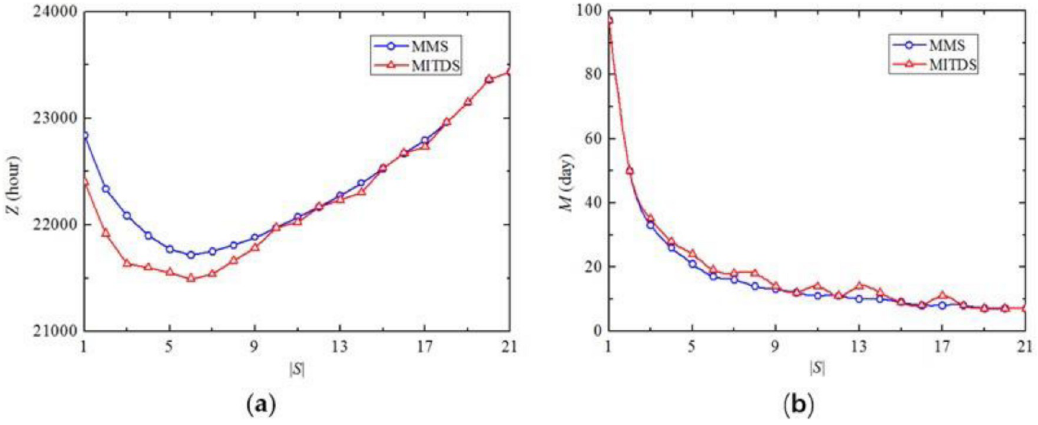
Fig 8. Z and M with the variation of | S | ( θ =